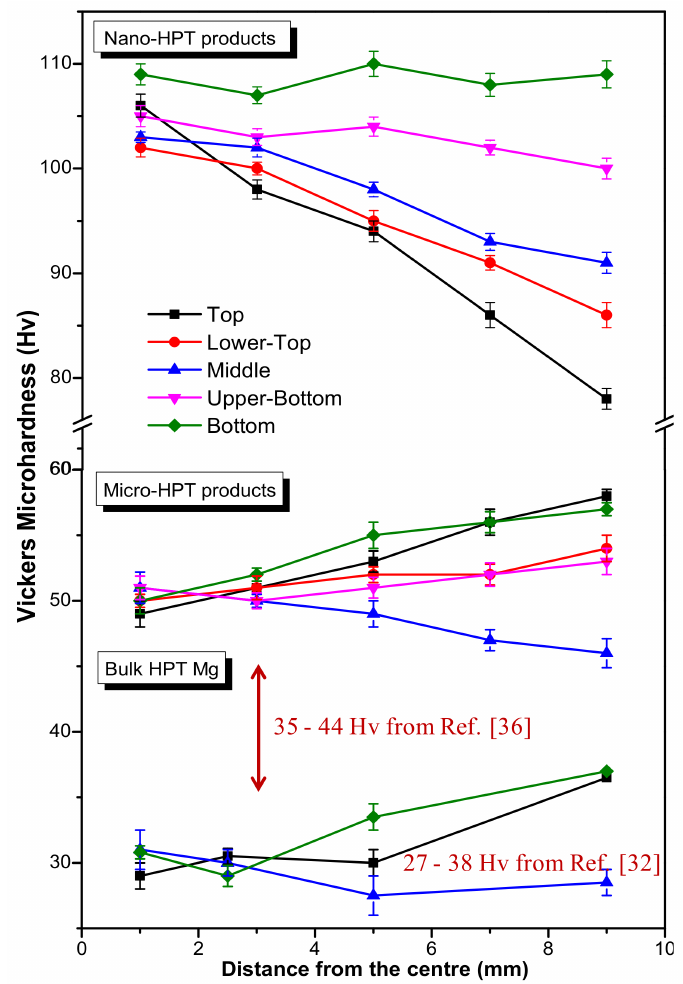
Figure 7. Variations of Vickers microhardness (Hv) along the radial direction as well as across the disk-thickness for the 2 turns nano-HPT and micro-HPT products. The reference hardness values for the HPT deformed bulk Mg samples are also included from Refs.